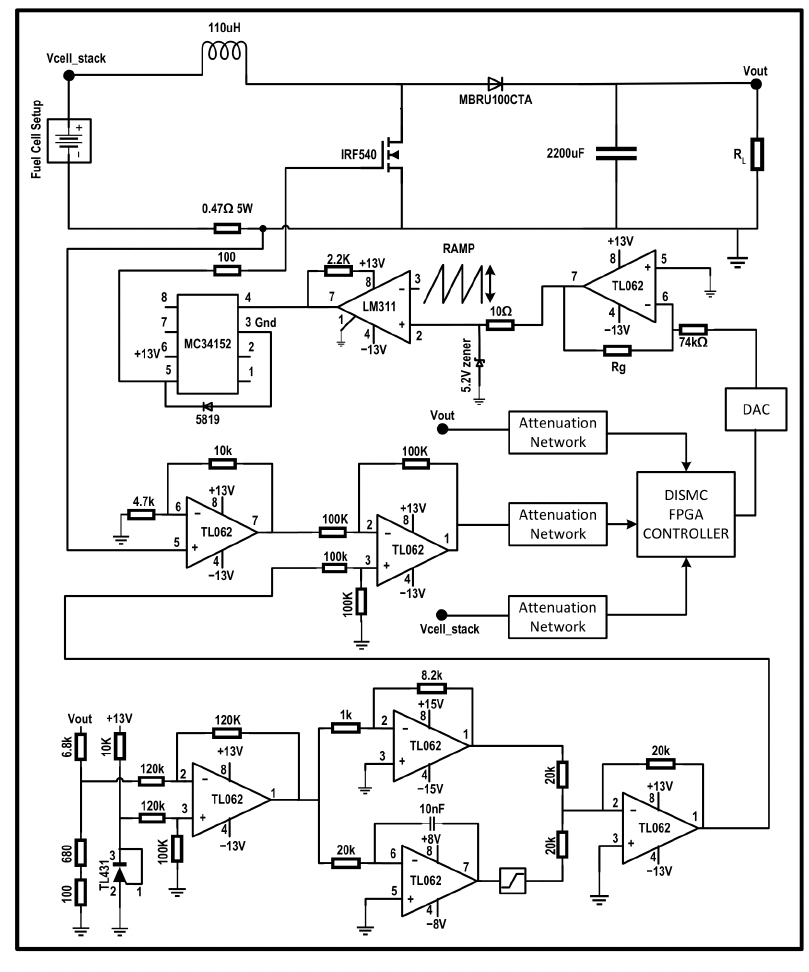
Figure 4. Schematic of the